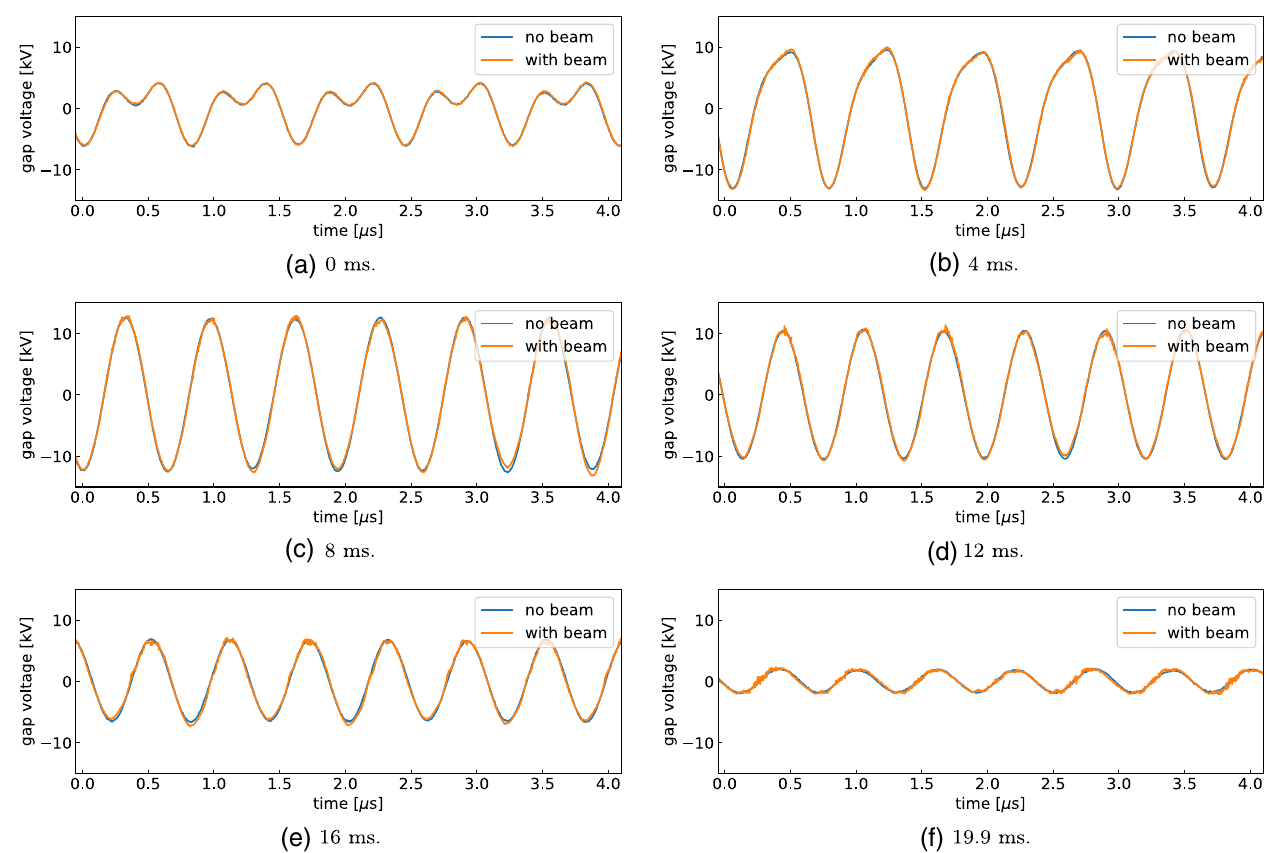
FIG. 35. Comparison of the gap voltage waveforms without and with a beam during